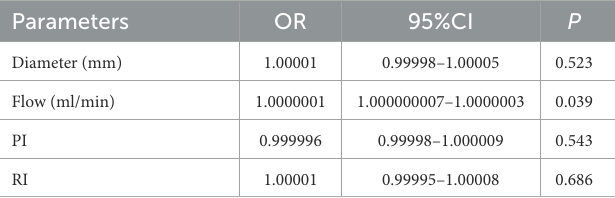
TABLE 3 GEE analysis of relationships between well-compensated collateral group (W group) and poorly-compensated collateral group (P group) at